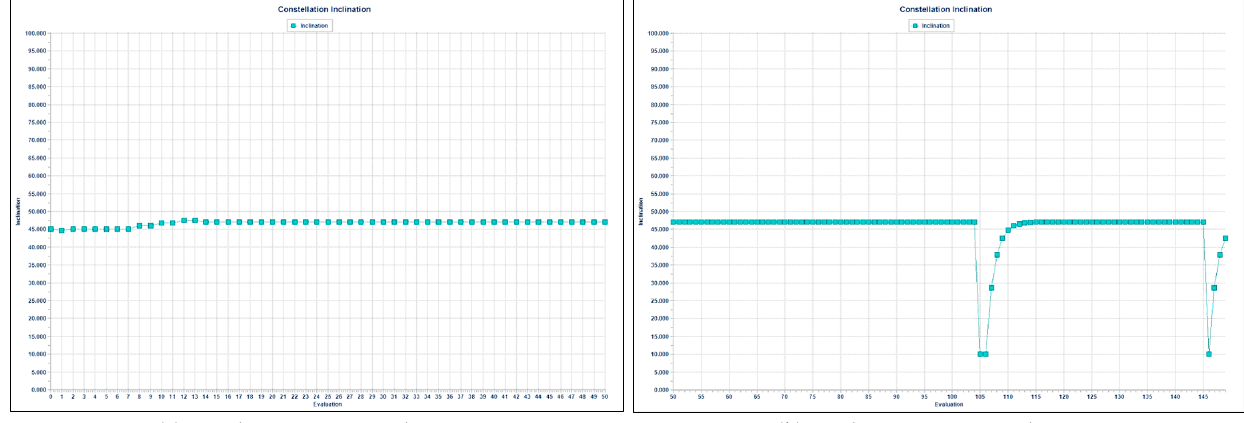
Figure 16. Inclination optimization process for the first 50 and concluding iterations.